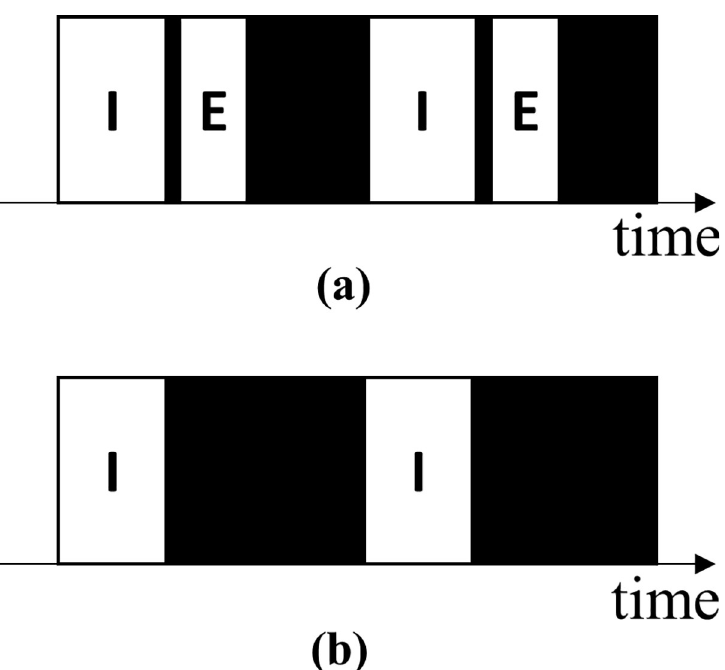
Fig 9. Patterns of normal breathing lung sounds. (a) General lung sound patterns and (b) general lung sound patterns with unidentifiable exhalations. “I” represents an identifiable inhalation event, “E” represents an identifiable exhalation event, and the black areas represent pause